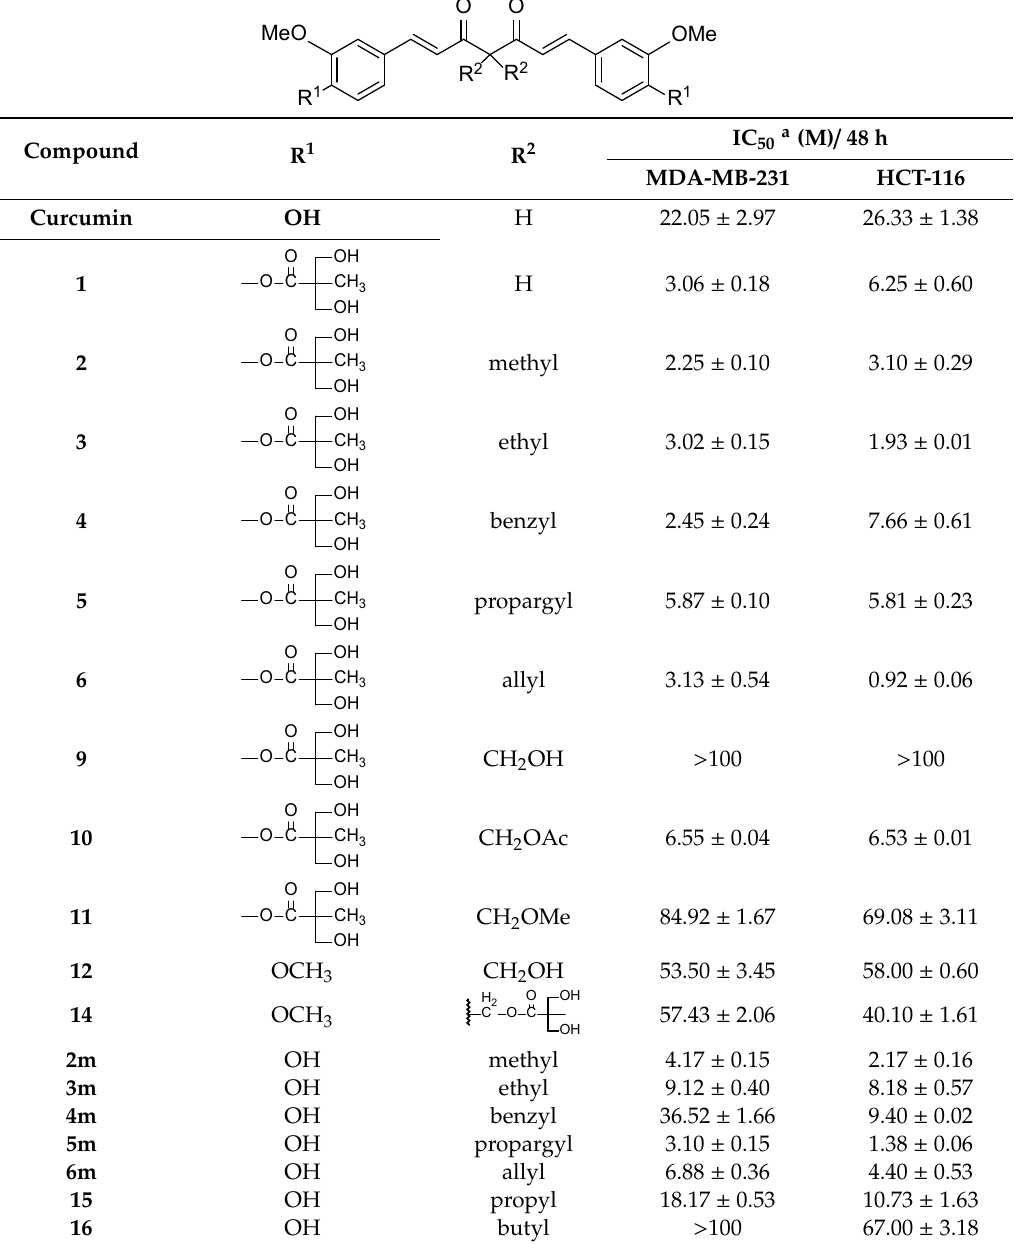
Table 1. The anti-proliferative effects of curcumin derivatives against MDA-MB-231 and HCT-116 cell lines.